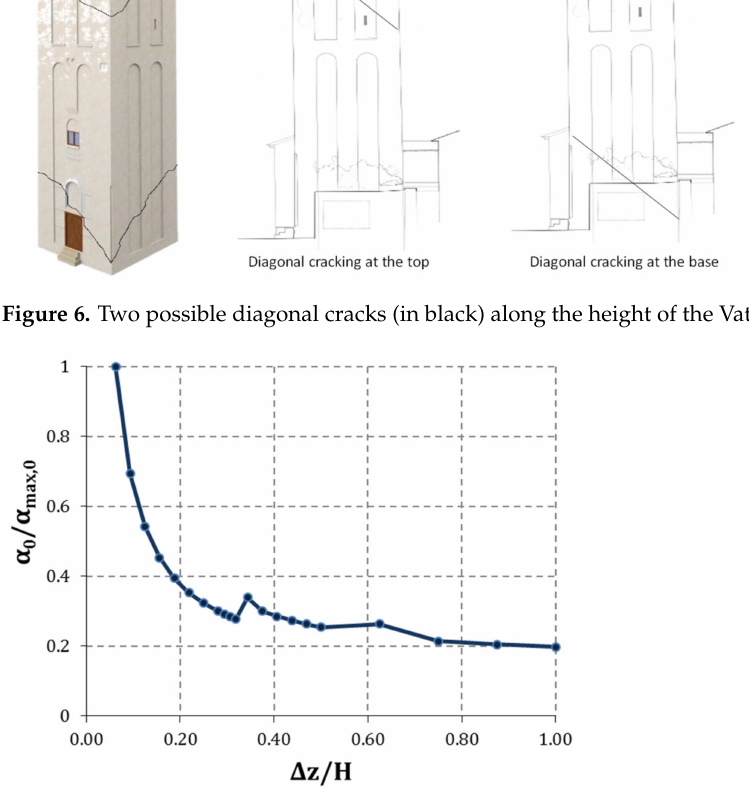
Figure 7. Variation of the acceleration needed to cause out-of-plane collapse.